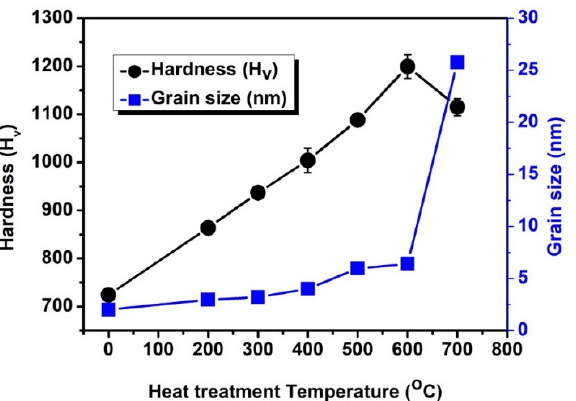
Figure 4. Effect of the grain size and heat treatment temperature on the hardness of the Ni-W/B composite coatings.